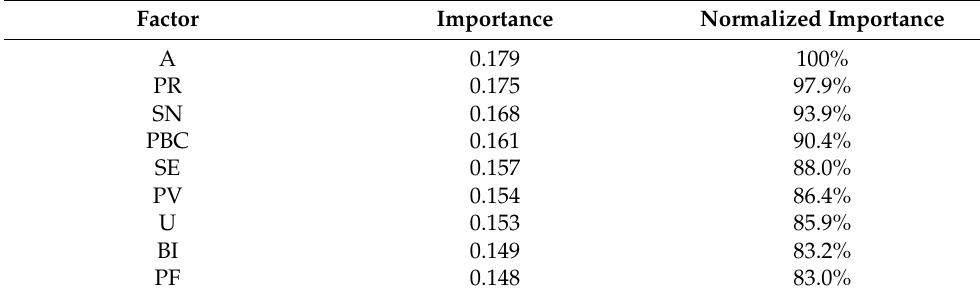
Table 7. Normalized Score of Importance.